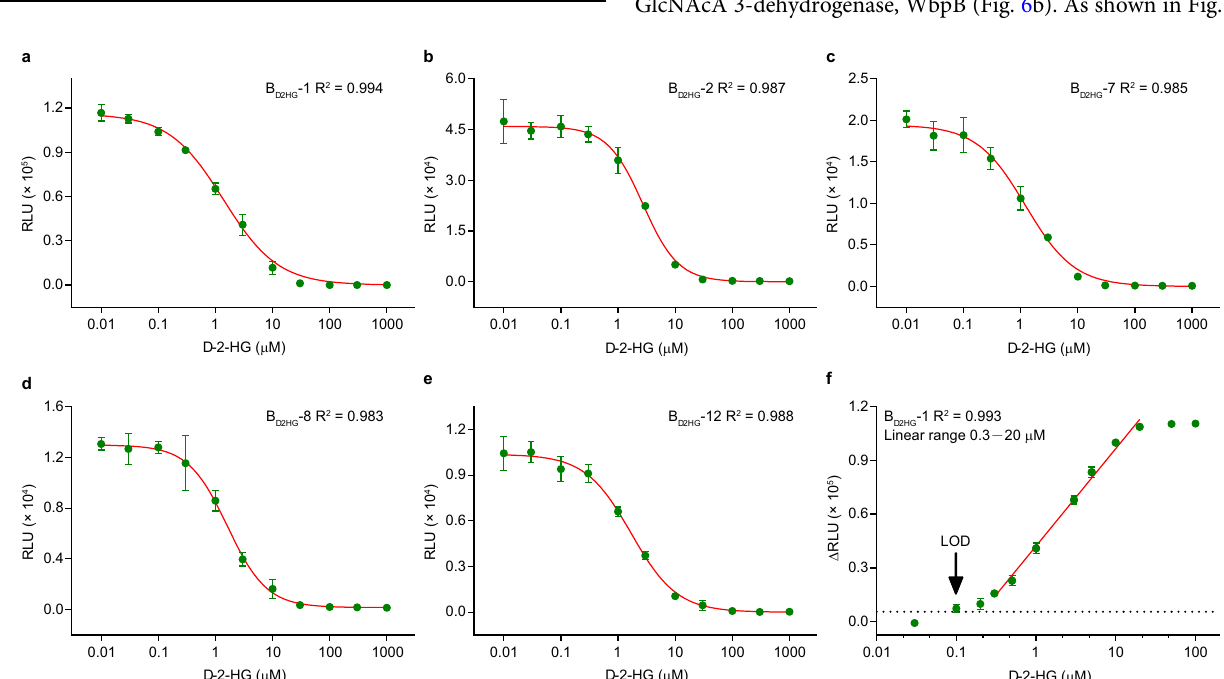
Fig. 4 Optimization of the D -2-HG biosensor (B ). a – e Responses of the optimized biosensors to different concentrations of D -2-HG. a Dose-response D 2HG curve of B -1; b dose-response curve of B -2; c dose-response curve of B -7; d dose-response curve of B -8; e dose-response curve of B - D 2HG D 2HG D 2HG D 2HG D 2HG 12. f The linear detection range of B -1. Black dotted line is a reference line where the reduced luminescence signal ( Δ RLU) is three times of the D 2HG background signal. The concentrations of DhdR and Bio- dhdO mutants in a – f were 0.3 and 1 nM, respectively. Data shown are mean ± s.d. ( n = 3 independent experiments). Source data are provided as a Source Data fi